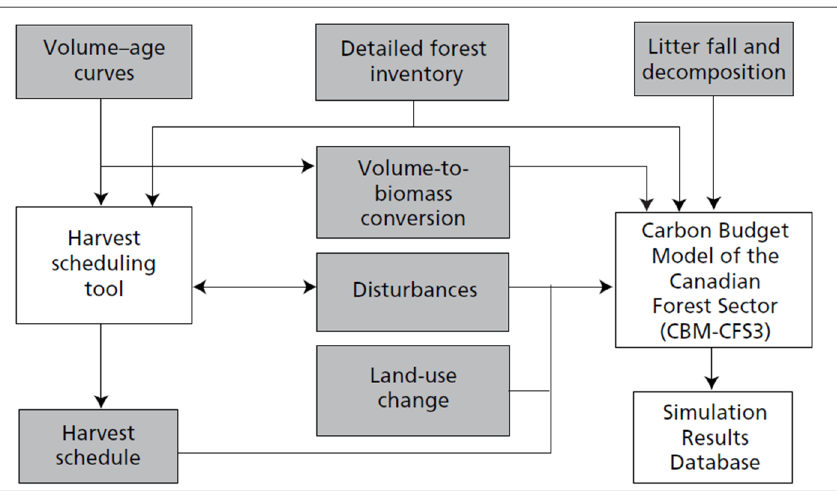
Figure 1. Chart representing input data (gray boxes) necessary to run simulation in Carbon Budget Model of the Canadian Forest Sector (CBM-CFS3) Reprinted/adapted with permission from Ref. [16].